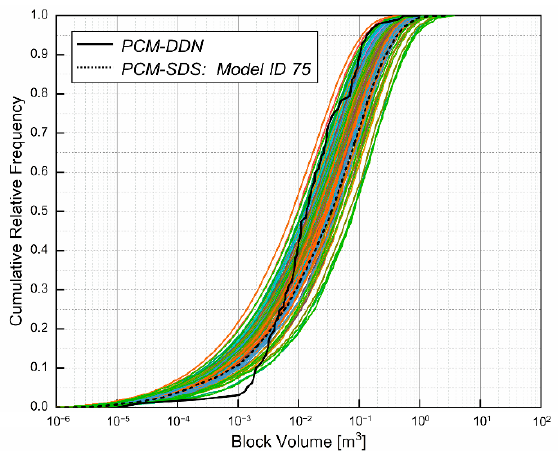
Figure 12. The block volume distribution of IBSD D and IBSD S . All color curves represent IBSD S from PCM-SDS of all simulated models.